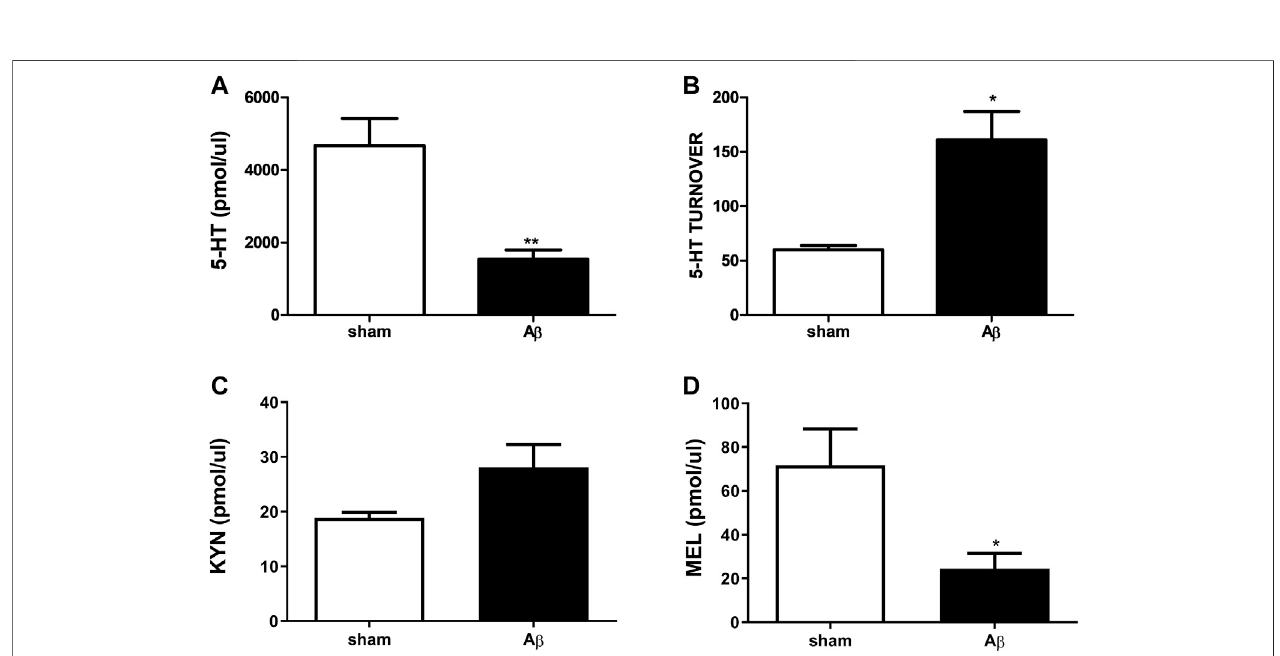
FIGURE6 | EffectsofA β administration on urinary 5-HT, 5-HT turnover, KYN and MEL. (A) 5-HT (pmol/ μ l) in sham (n (cid:1) 4) and A β -treated (n (cid:1) 4) animals. Unpaired Student ’ st-test,** p < 0.01A β vssham. (B) 5-HT turnoverinsham(n (cid:1) 4)andA β -treated (n (cid:1) 4)animals.UnpairedStudent ’ st-testwithWelch ’ scorrection,* p < 0.05A β vs sham. (C) KYN (pmol/ μ l) in sham (n (cid:1) 5) and A β -treated (n (cid:1) 5) animals. Unpaired Student ’ s t-test, p > 0.05 A β vs sham. (D) MEL (pmol/ μ l) in sham (n (cid:1) 5) and A β - treated (n (cid:1) 5) animals. Unpaired Student ’ s t-test, * p < 0.05 A β vs sham.